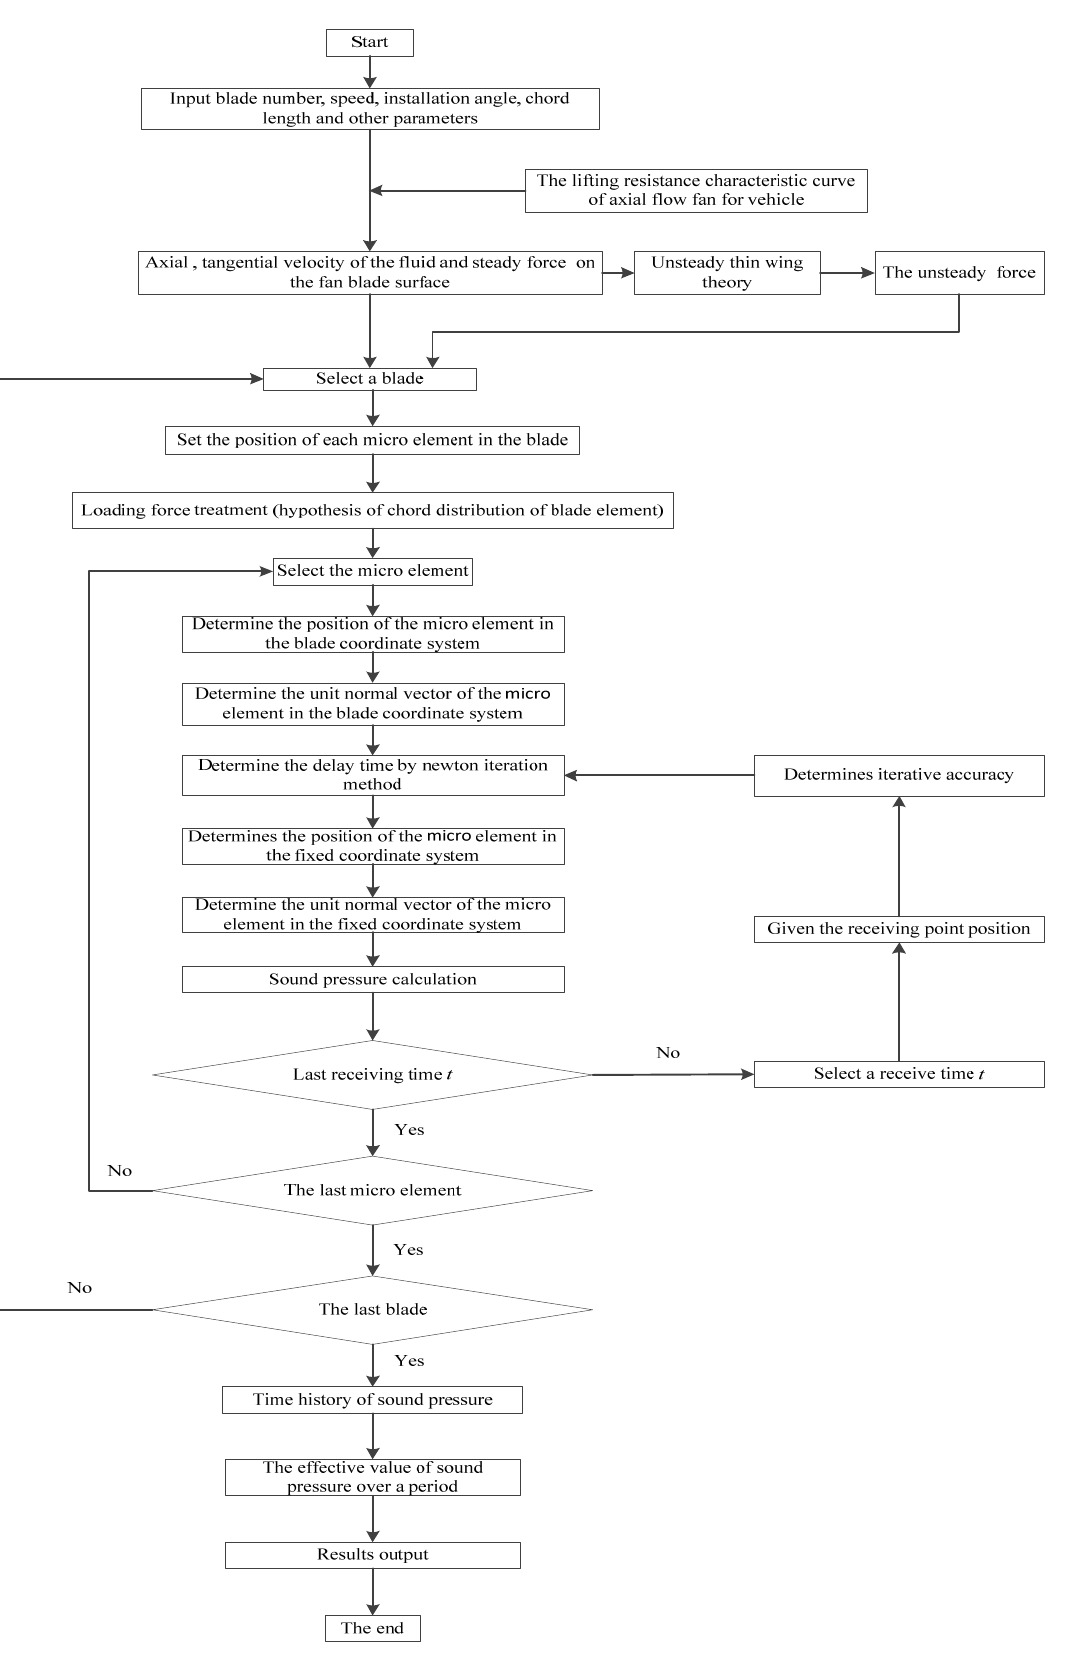
Figure 3. Calculation flow chart.